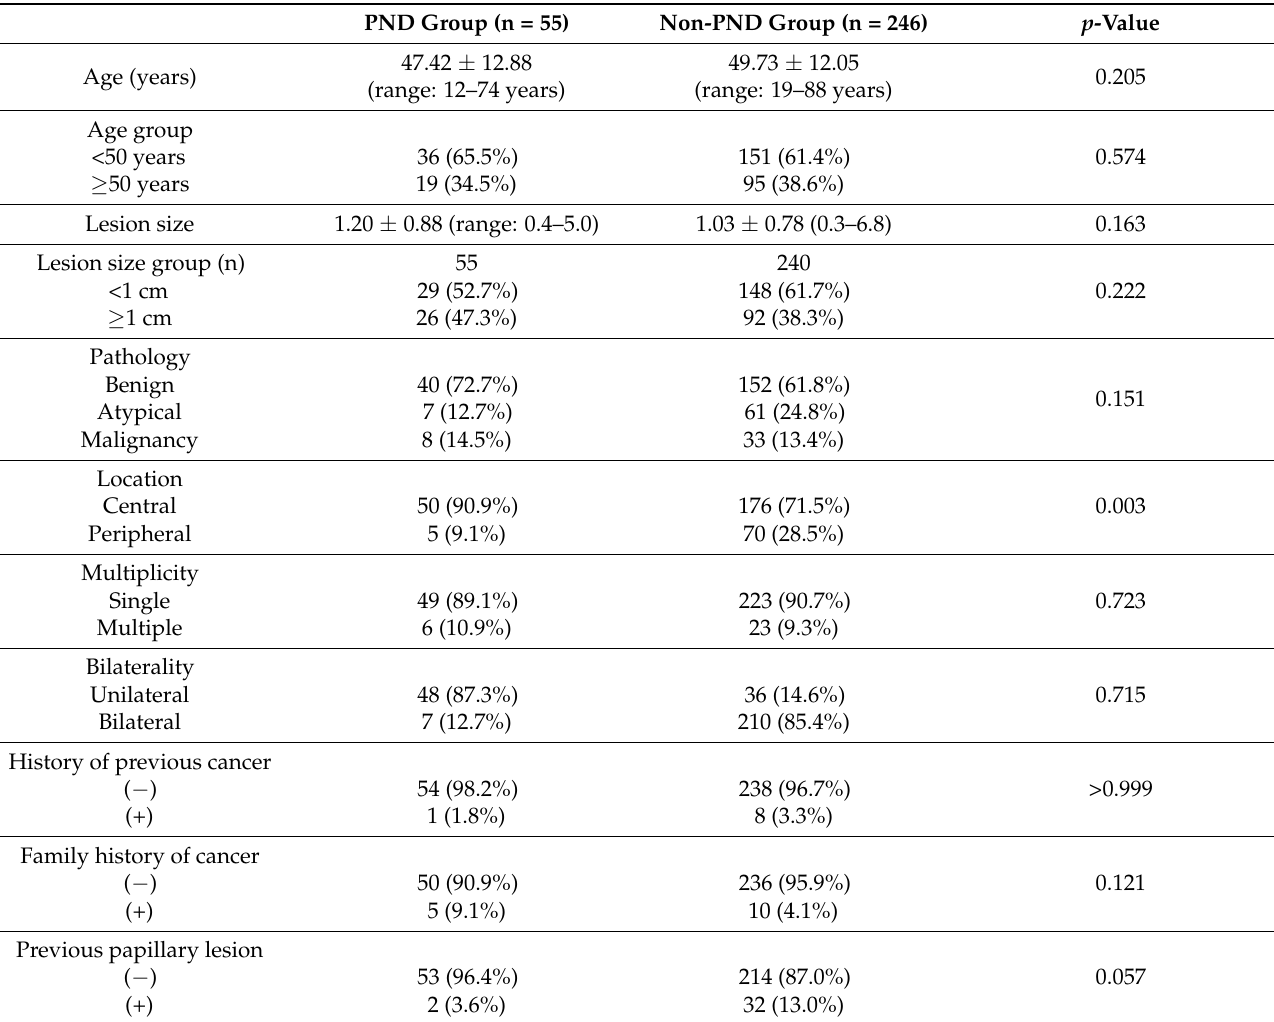
Table 4. Clinical characteristics of papillary lesions, classified according to pathologic nipple discharge.